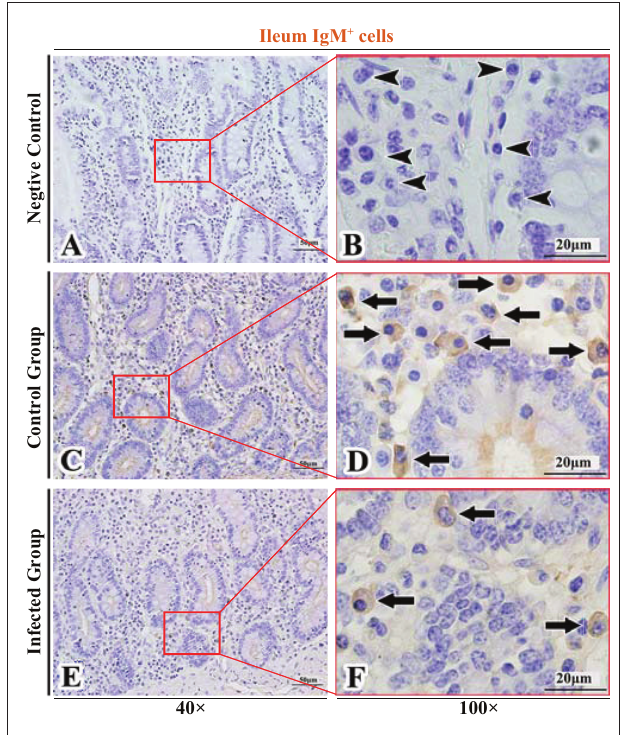
FIGURE 9 | Distribution of IgG + cells in sheep ileum. (A,B) are negative controls; (C,D) are Control groups; (E,F) are Infected groups. Triangular arrows indicated plasma cells, arrows indicated IgG + cells, and the right image (Scale bar, 20 µ m) is a magnification from the part of the left image (Scale bar, 50 µ m).